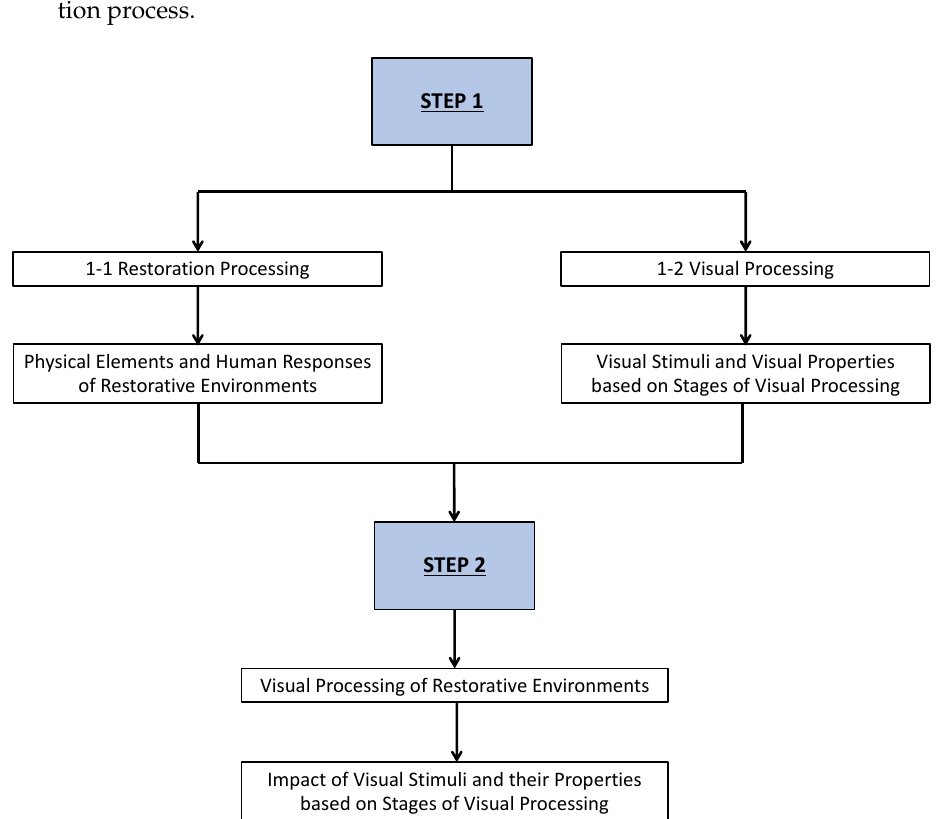
Figure 1. Two steps of conducting a literature review.